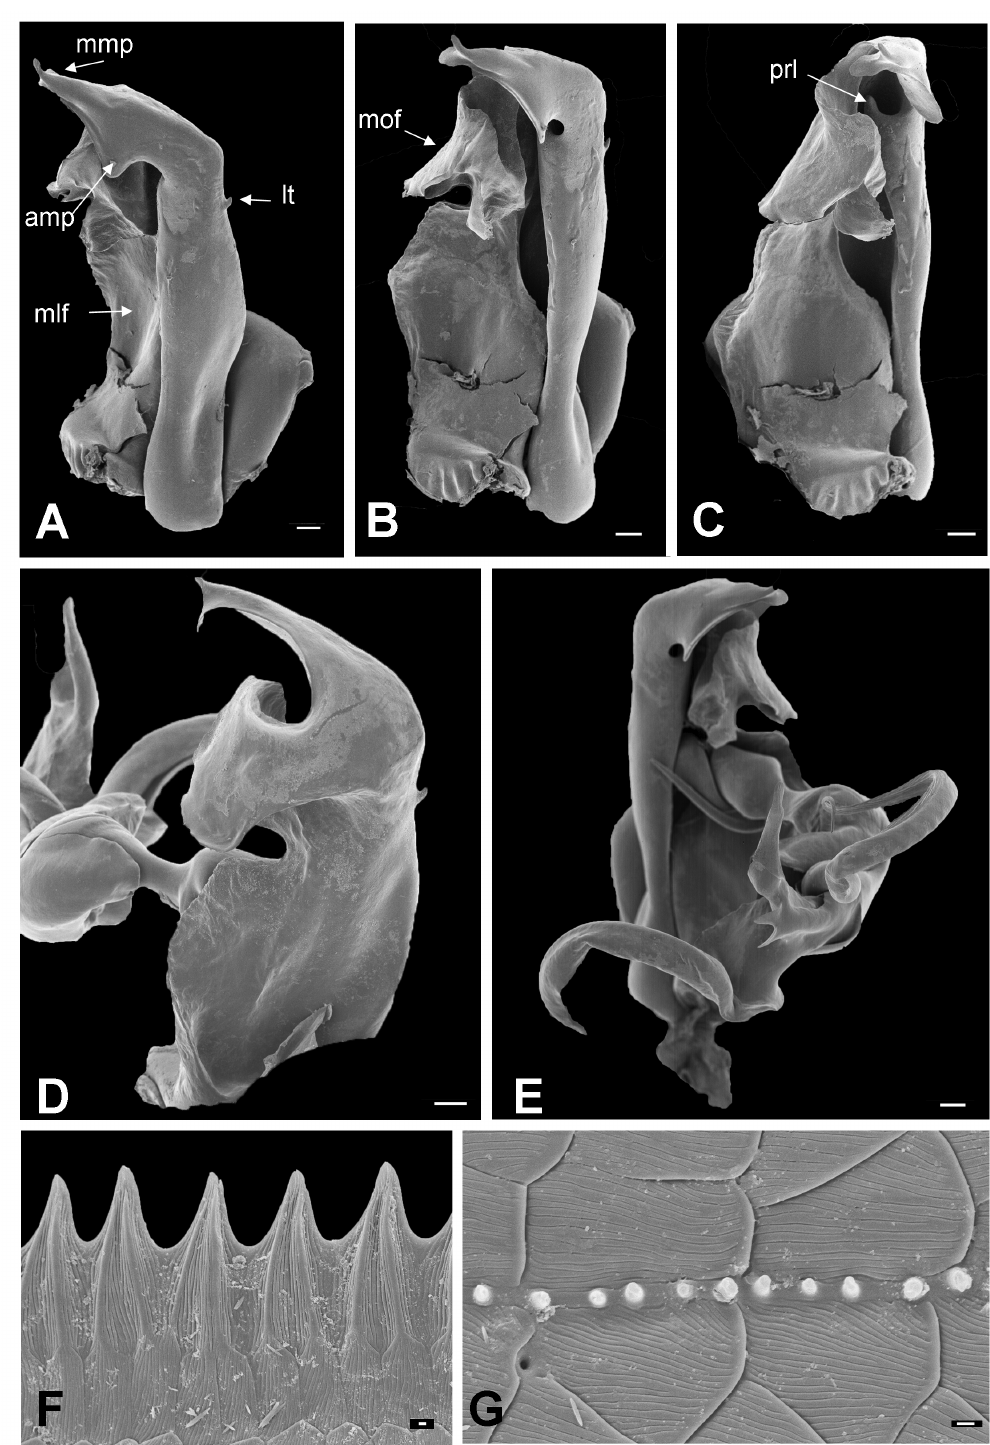
Fig. 5. Prionopetalum kraepelini (Attems, 1896), specimen from Mang’ula, 339 m asl. A – C . Right gonopod coxa. A. Anterior view. B. Anterior-mesal view. C. Mesal view. D – E . Left gonopod. D. Posterior view. E. Anterior-mesal view. F . Midbody-dorsal limbus. G . Row of intercalary micro- scutes with knobs, from midbody metazona. Abbreviations: amp = anterior metaplical process; lt = lateral coxal tubercle; mlf = metaplical longitudinal flange; mmp = distomesal metaplical process; mof = metaplical oblique/horizontal flange; prl = proplical lobe. Scale bars: A–E = 0.1 mm; F–G = 0.001